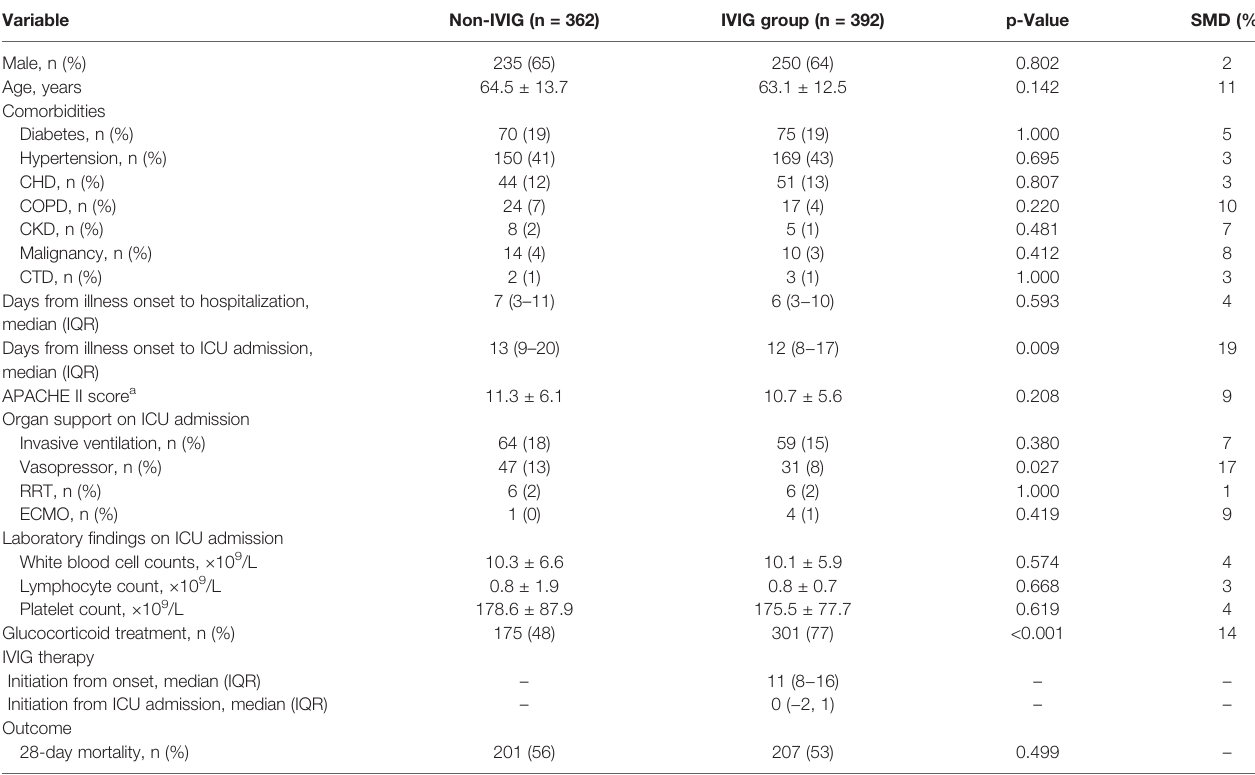
TABLE 1 | Clinical characteristics of 754 patients with COVID-19 included in the study according to IVIG treatment.